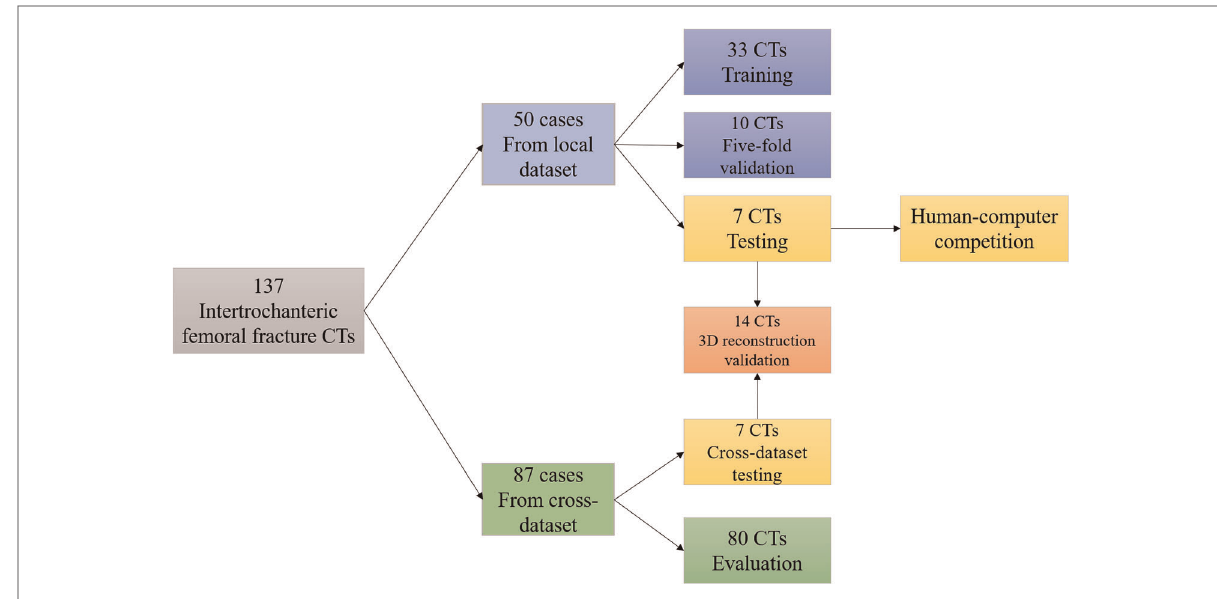
FIGURE 1 Data sources and distribution of 137 intertrochanteric femoral fracture